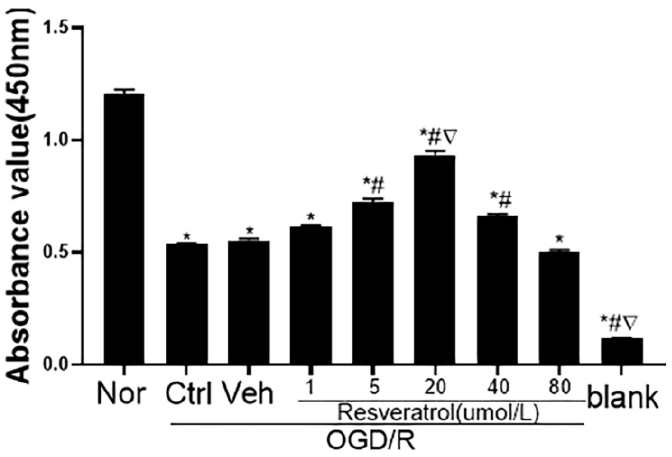
Figure 1. Concentration effect of resveratrol on the viability of N9 microglia following OGD/R injury. The viability of N9 microglia was detected with the CCK-8 assay. * p < 0.05, vs. Nor group; # p < 0.05, vs. Ctrl group; ▽ p < 0.05, vs. Res5 and Res40 groups. Data are presented as the mean ± standard deviation and were compared using a one-way analysis of variance ( n = 3 for each group). OGD/R, oxygen-glucose deprivation/reoxygenation; Nor, normal; Ctrl, control; Veh, vehicle; Res, resveratrol.